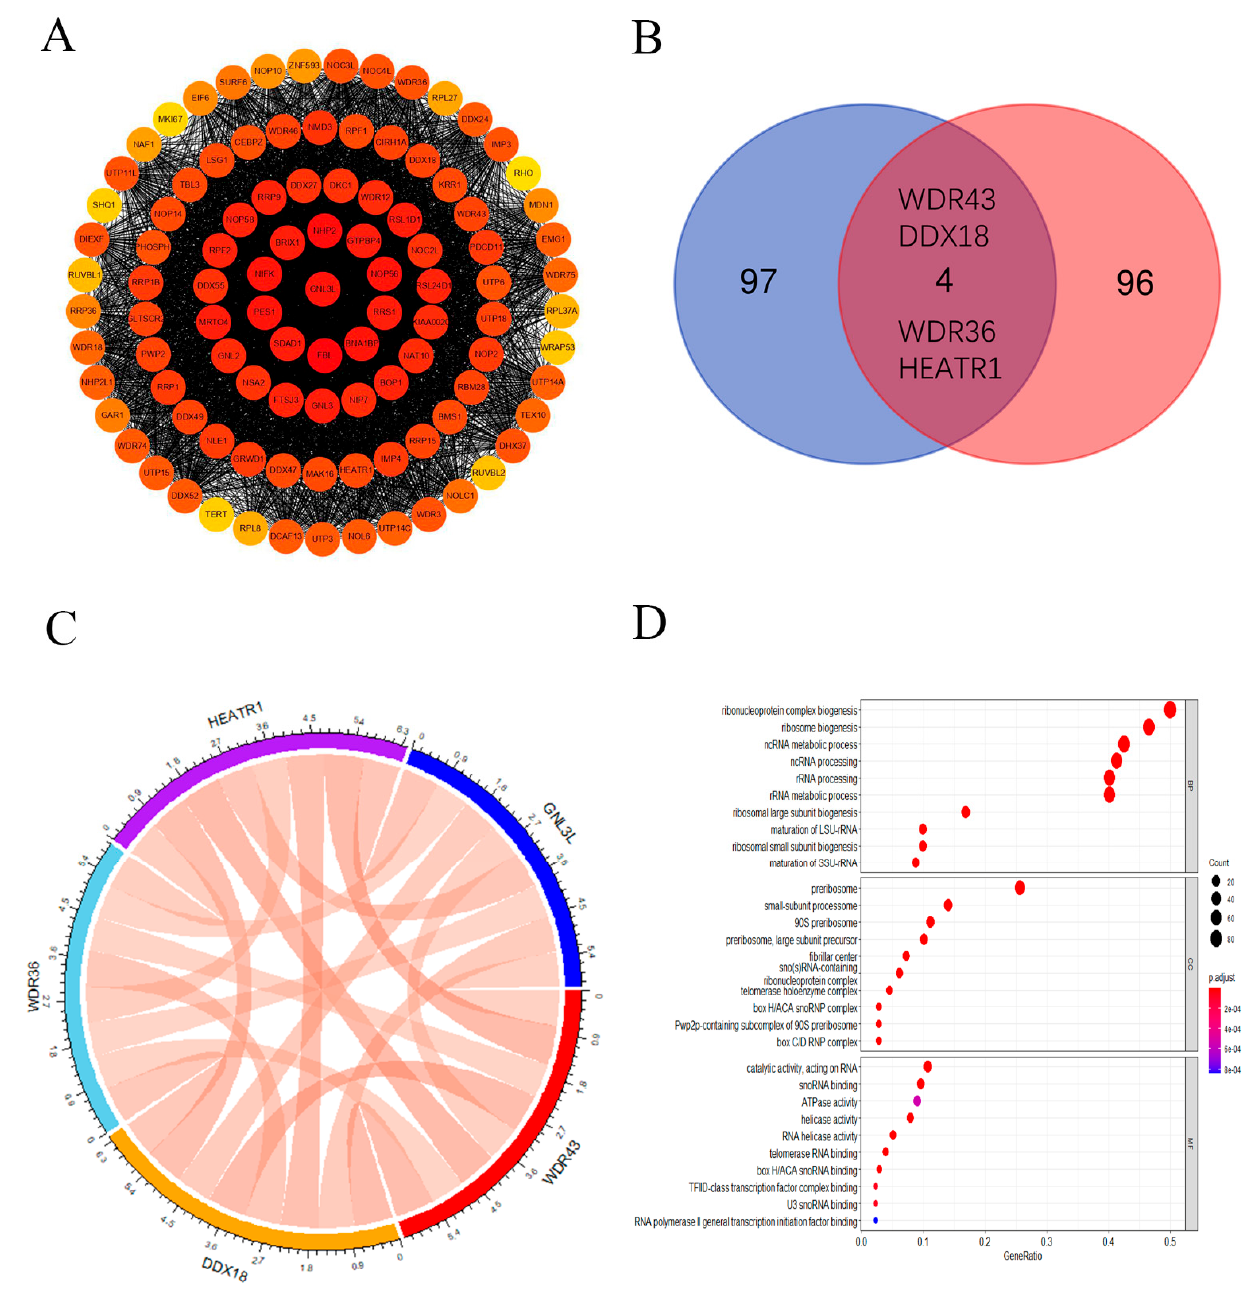
Figure 10. GNL3L-related gene enrichment analysis. ( A ) Co-expression network of GNL3L genes displayed in Cytoscape software. ( B ) Venn diagram of the genome based on the STRING database and the GEPIA2 database. ( C ) GNL3L, WDR43, DDX18, WDR36, and HEATR1 gene expression correlation chord plots. ( D ) Plot of the results of the GO enrichment analysis of GNL3L and its related genes.